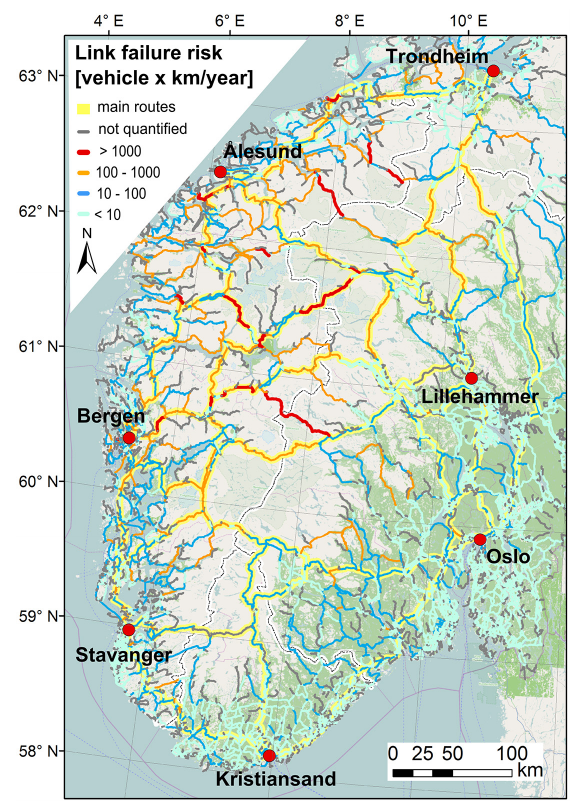
Figure 7. Estimated annual link risk expressed as vehicle km; main routes between seven large cities in southern Norway are marked in